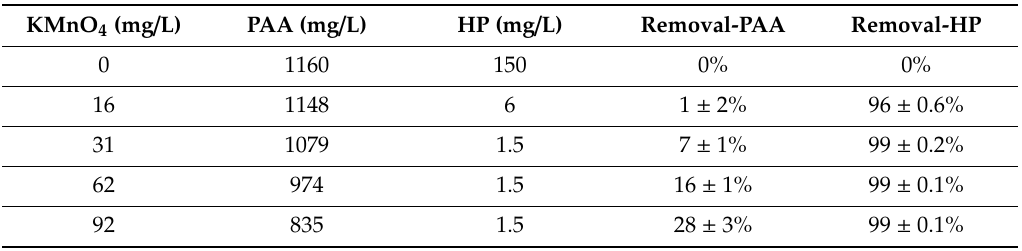
Table 1. Removal of peracetic acid (PAA) and H 2 O 2 after titration with di ff erent concentrations of KMnO 4 (mean ± standard deviation, n = 3). KMnO 4 (mg / L) PAA (mg / L) HP (mg / L) Removal-PAA